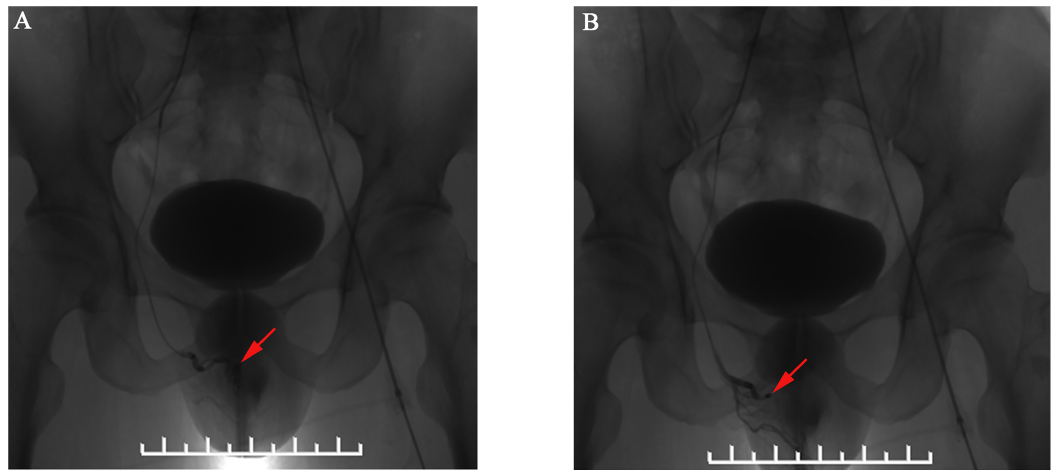
Fig. 4. Superselective embolization of the internal pudendal artery. (A) Selective arteriography of the internal pudendal artery showed abnormal blood perfusion and local aggregation of contrast medium (indicated by arrow). (B) After superselective embolization of the internal pudendal artery with polyvinyl alcohol particles (indicated by arrow), the abnormal blood perfusion had